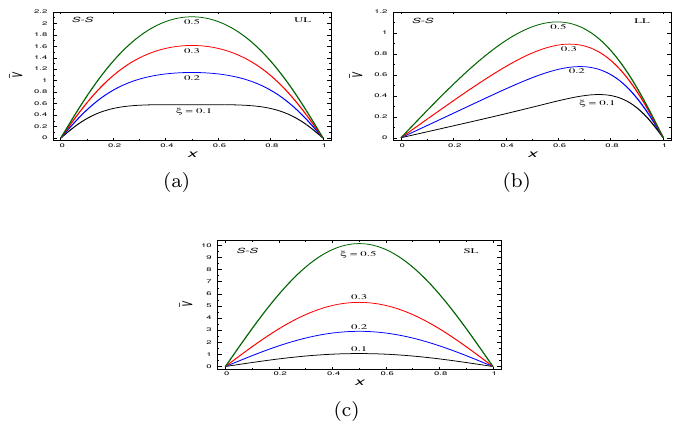
Figure 3. Effect of nonlocal parameter ξ on the distribution of angular displacement along the axial direction of a S-S CNT subjected to: (a) UL, (b) LL, and (c) SL.